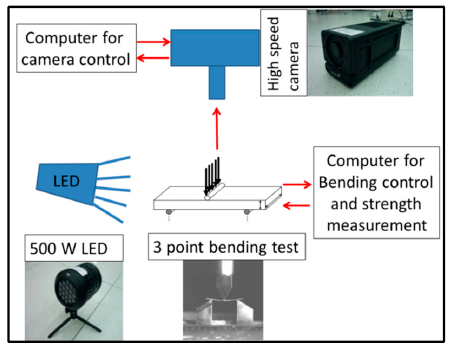
Figure 2. Schematic diagram for fragmentation analysis using three-point bending test.